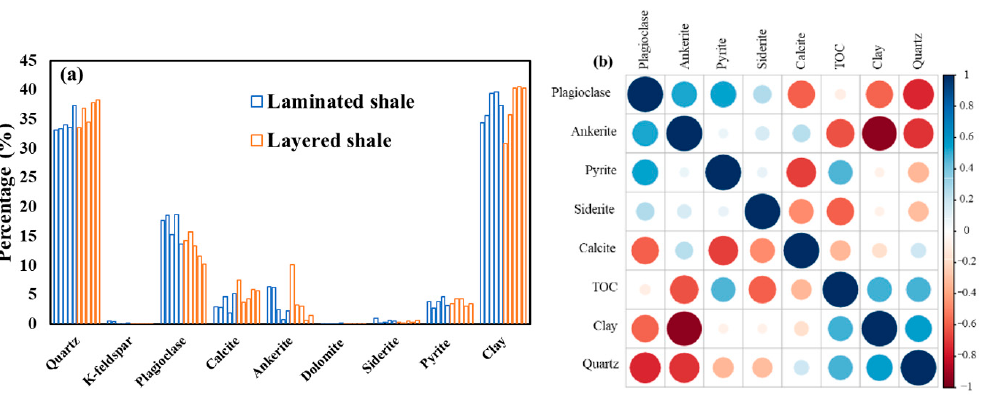
Figure 2. ( a ) Mineralogy analysis from 5 wells in the first member; and ( b ) mineral correlation analysis.